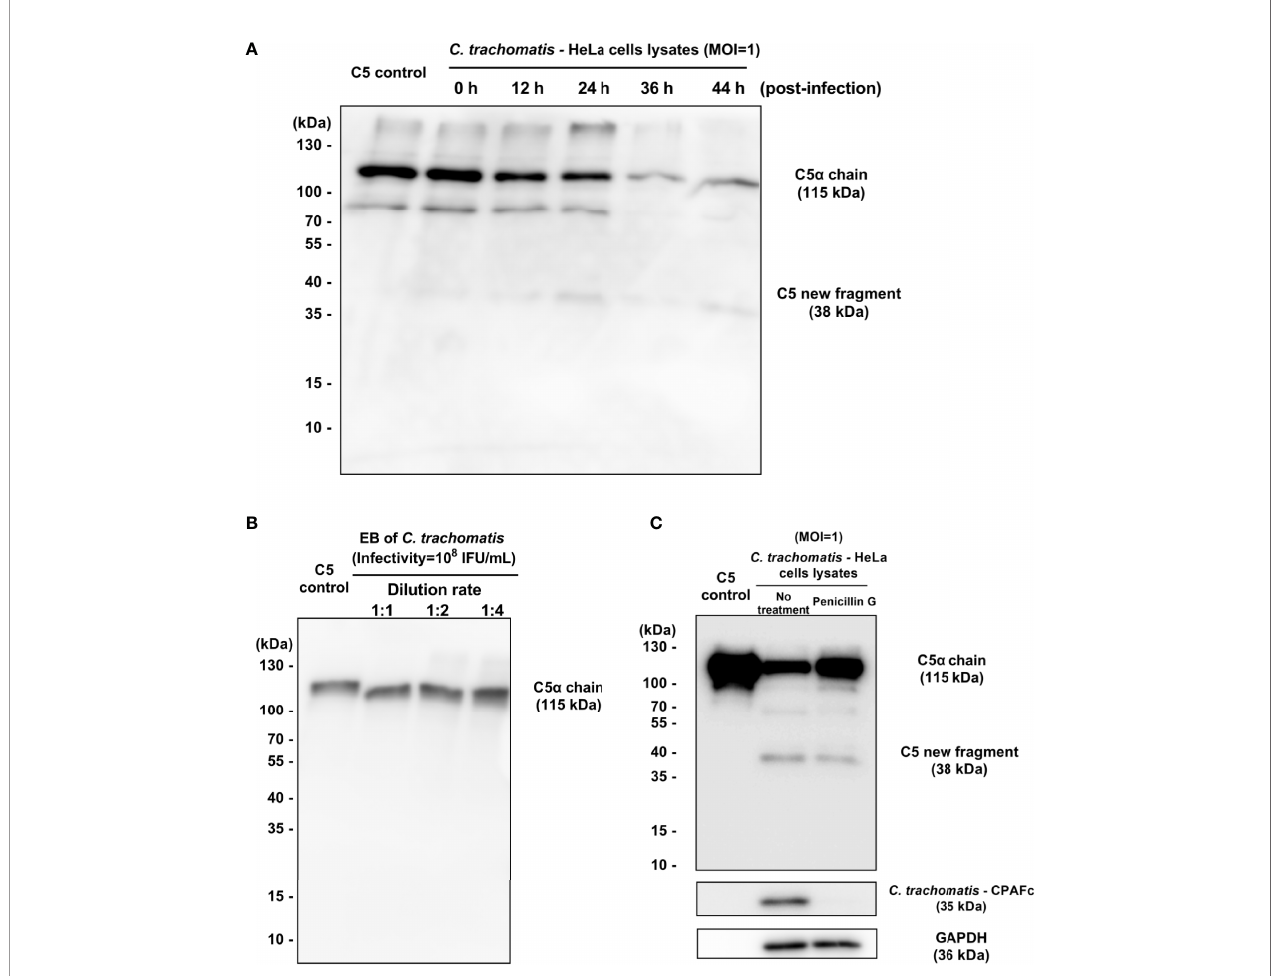
FIGURE 4 | Chlamydial infection after 24 hours post-infection but not EB cleaves C5 at K970 site. (A) The (C) trachomatis-HeLa229 cell lysates (MOI=1) collected at 0 h, 12 h, 24 h, 36h and 44 h post-infection were co-incubated with puri fi ed C5 (400 nM) for 120 min. Western blot analysis showed the fragments encompassing C5a. (B) The puri fi ed chlamydial EBs were co-incubated with puri fi ed C5 (400 nM) for 30 min. Western blot analysis showed the fragments encompassing C5a. (C) Penicillin treatment signi fi cantly reduced the consumption of the band of C5 a chain, and also inhibited the expression of